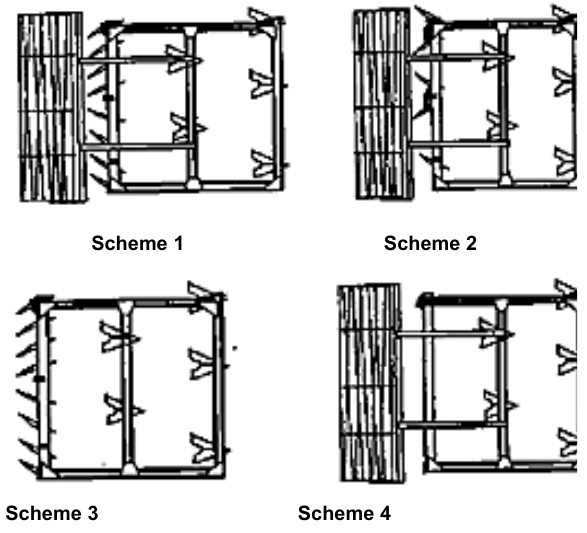
Figure 1. Variants of technological schemes Scheme 3 - Flat cutting working bodies with a working width of 500 mm installed in two rows, spherical disk working bodies ∅ 450 mm (installed in one row with an attack angle of 20